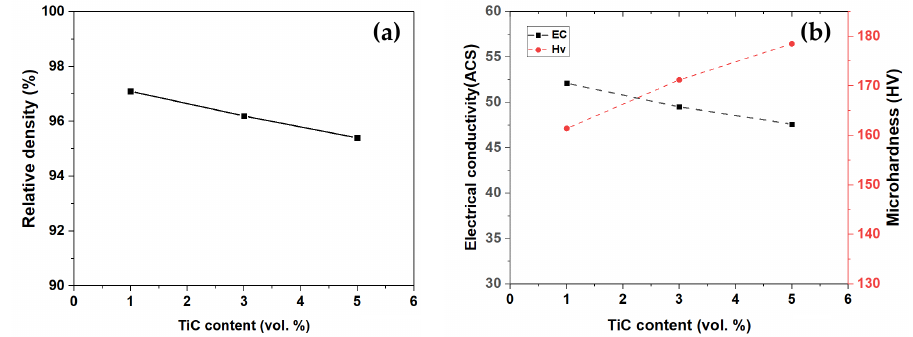
Figure 5. Properties of Cu-TiC composite samples sintered at 600 ◦ C with di ff erent vol. % TiC: ( a ) relative density of the composites and ( b ) electrical conductivity versus microhardness. Table 2. Relative density of nanocomposites sintered at di ff erent